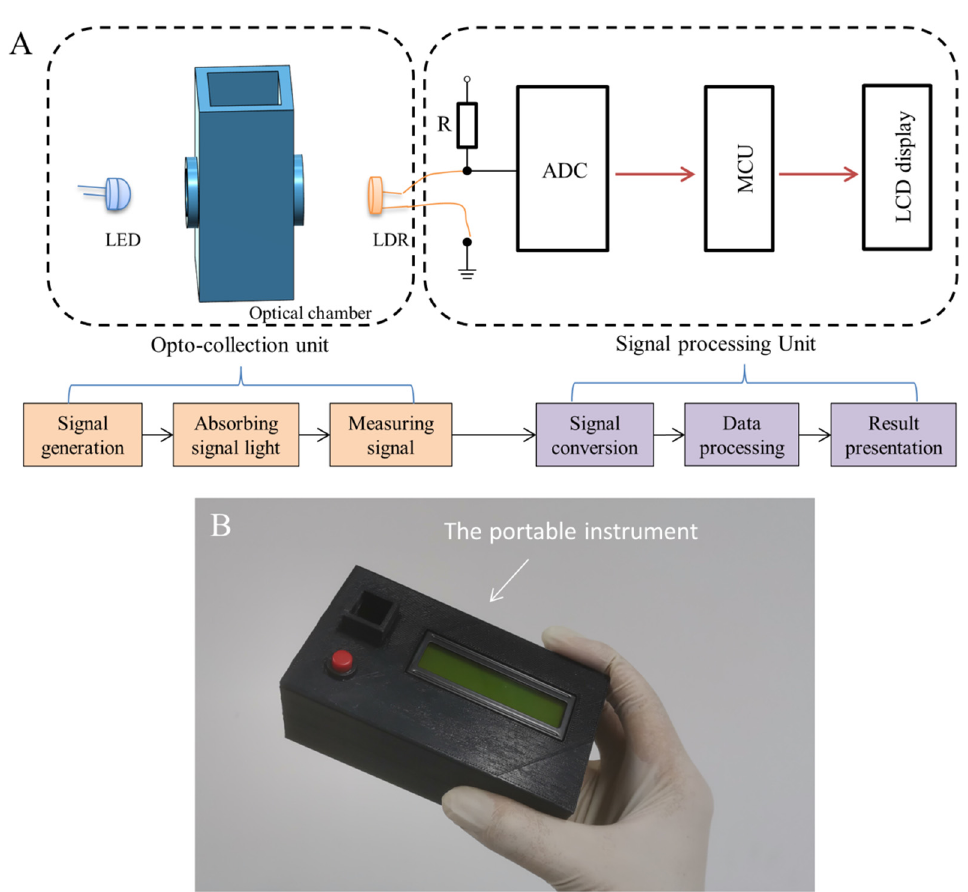
Figure 1. Design and fabrication of the instrument. ( A ) The structure of the optical chamber and schematic illustration of the portable instrument composed of the opto-collection unit (orange) and the signal processing unit (purple). ( B ) Photograph of the portable instrument.